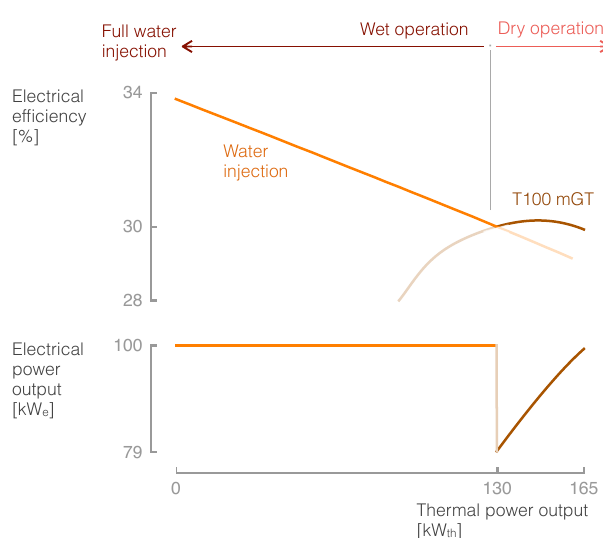
Figure 4. When the heat demand is between 130kW th and 165kW th , it is not worth injecting water as the electrical efficiency actually reduces. For heat demand values below 130kW th , the mHAT operates at a full electrical load with water injection.